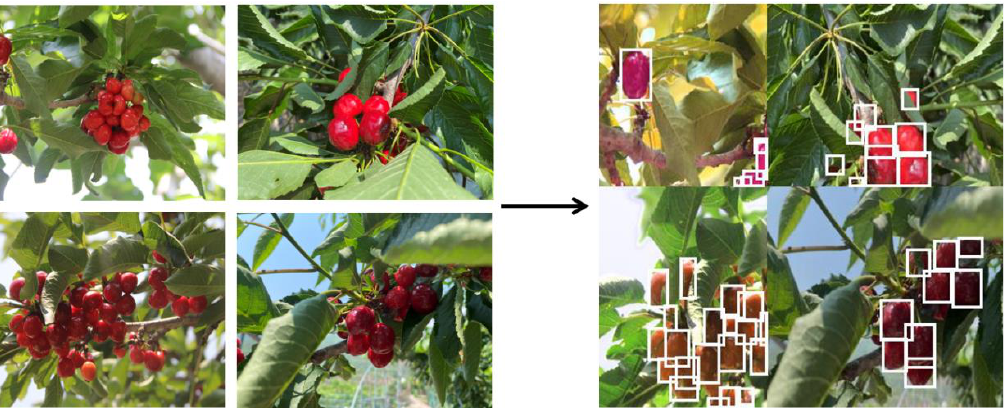
Figure 4. Mosaic image enhancement: Random selection of four cherry images, gamut change, flip, zoom, combined images, combo box.